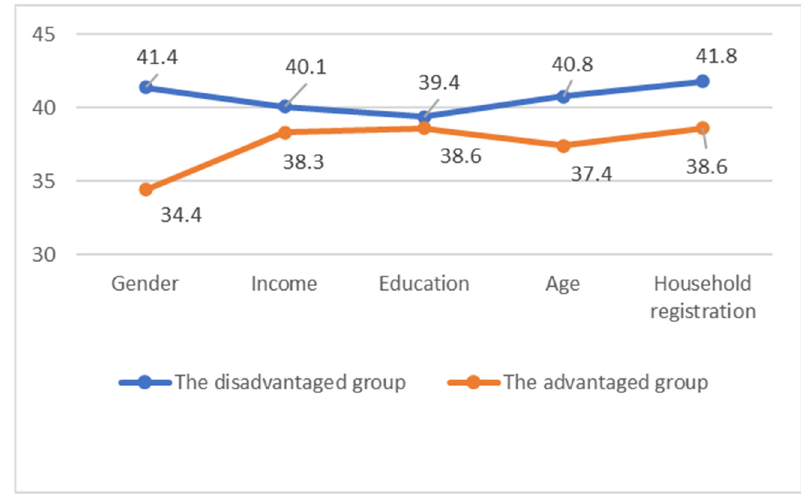
Figure 2. The comparison of the prevalence of depression among relatively disadvantaged and relatively advantaged groups (%).